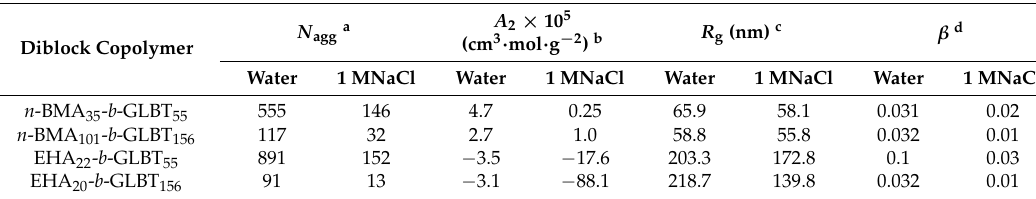
Table 2. Micellar properties of ZABC